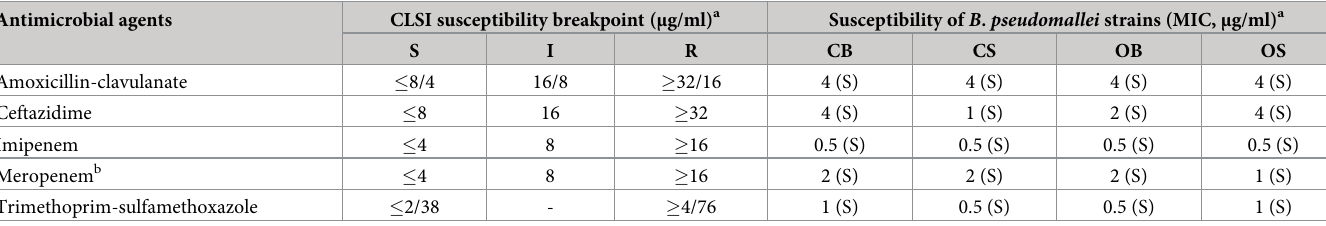
Table 5. Antimicrobial susceptibility profiles of Burkholderia pseudomallei strains. Antimicrobial